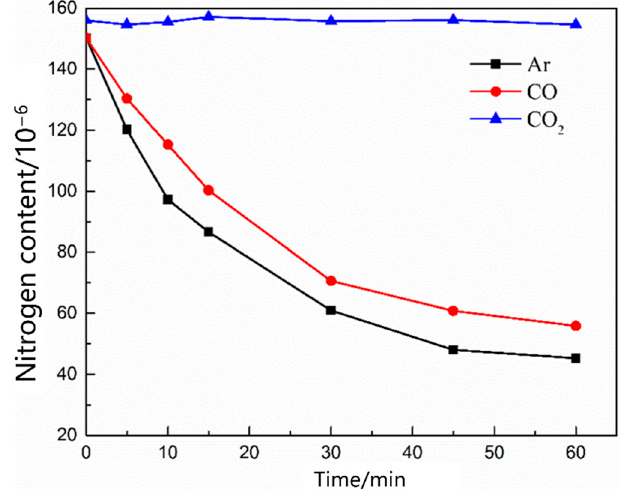
Figure 17. Change in the nitrogen content in the liquid steel with 0.026% oxygen content injected with different gases.